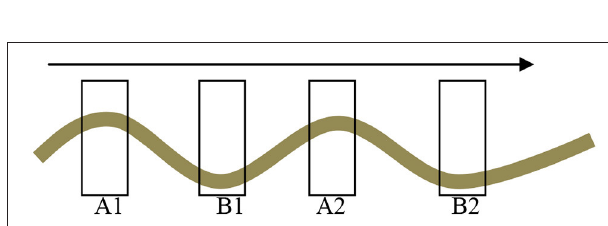
FIGURE 3 | Division of Interpretation Layer of Horizontal